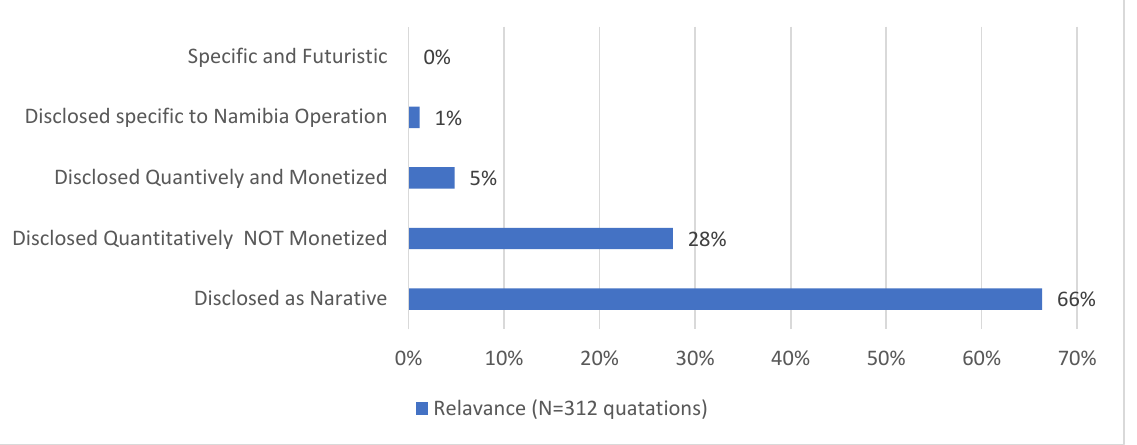
Figure 5. Nature of disclosure of decision usefulness characteristics. Source: Authors’ own illustration. (Please note that n = 312 represents the number of observations (i.e., 312 in the case of relevance) for the specific qualitative characteristic).